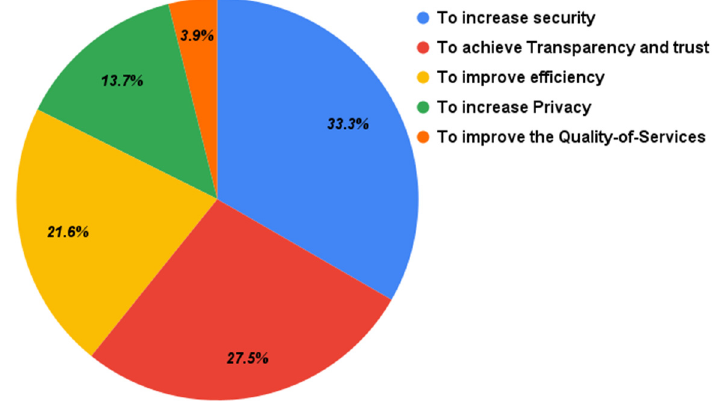
Figure 4. Motivations of adopting a hybrid blockchain.